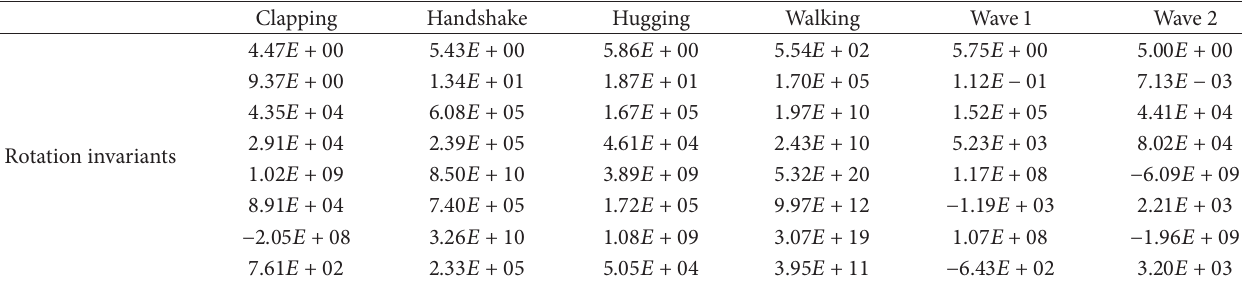
Table 5: The numerical comparison of rotation invariant moments for each of the actions.